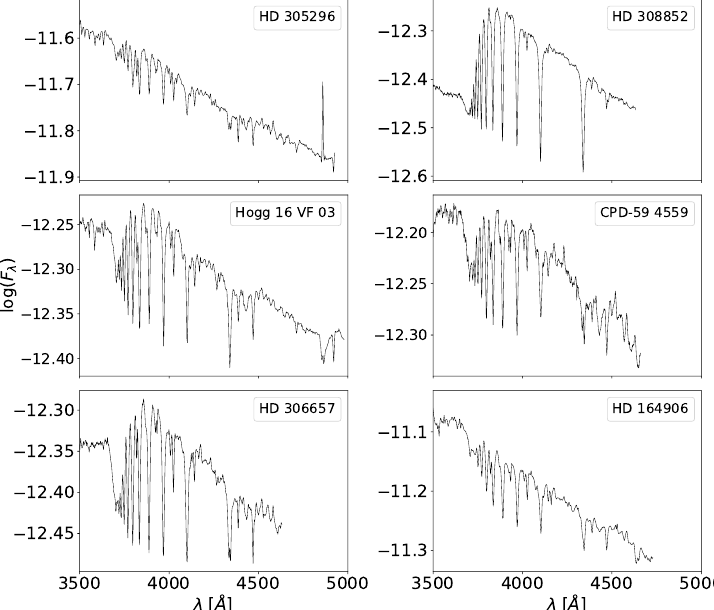
Figure 7. Low-resolution flux-calibrated spectra taken in CASLEO for Be stars in clusters with the scBD in emission. Adapted from Aidelman et al.